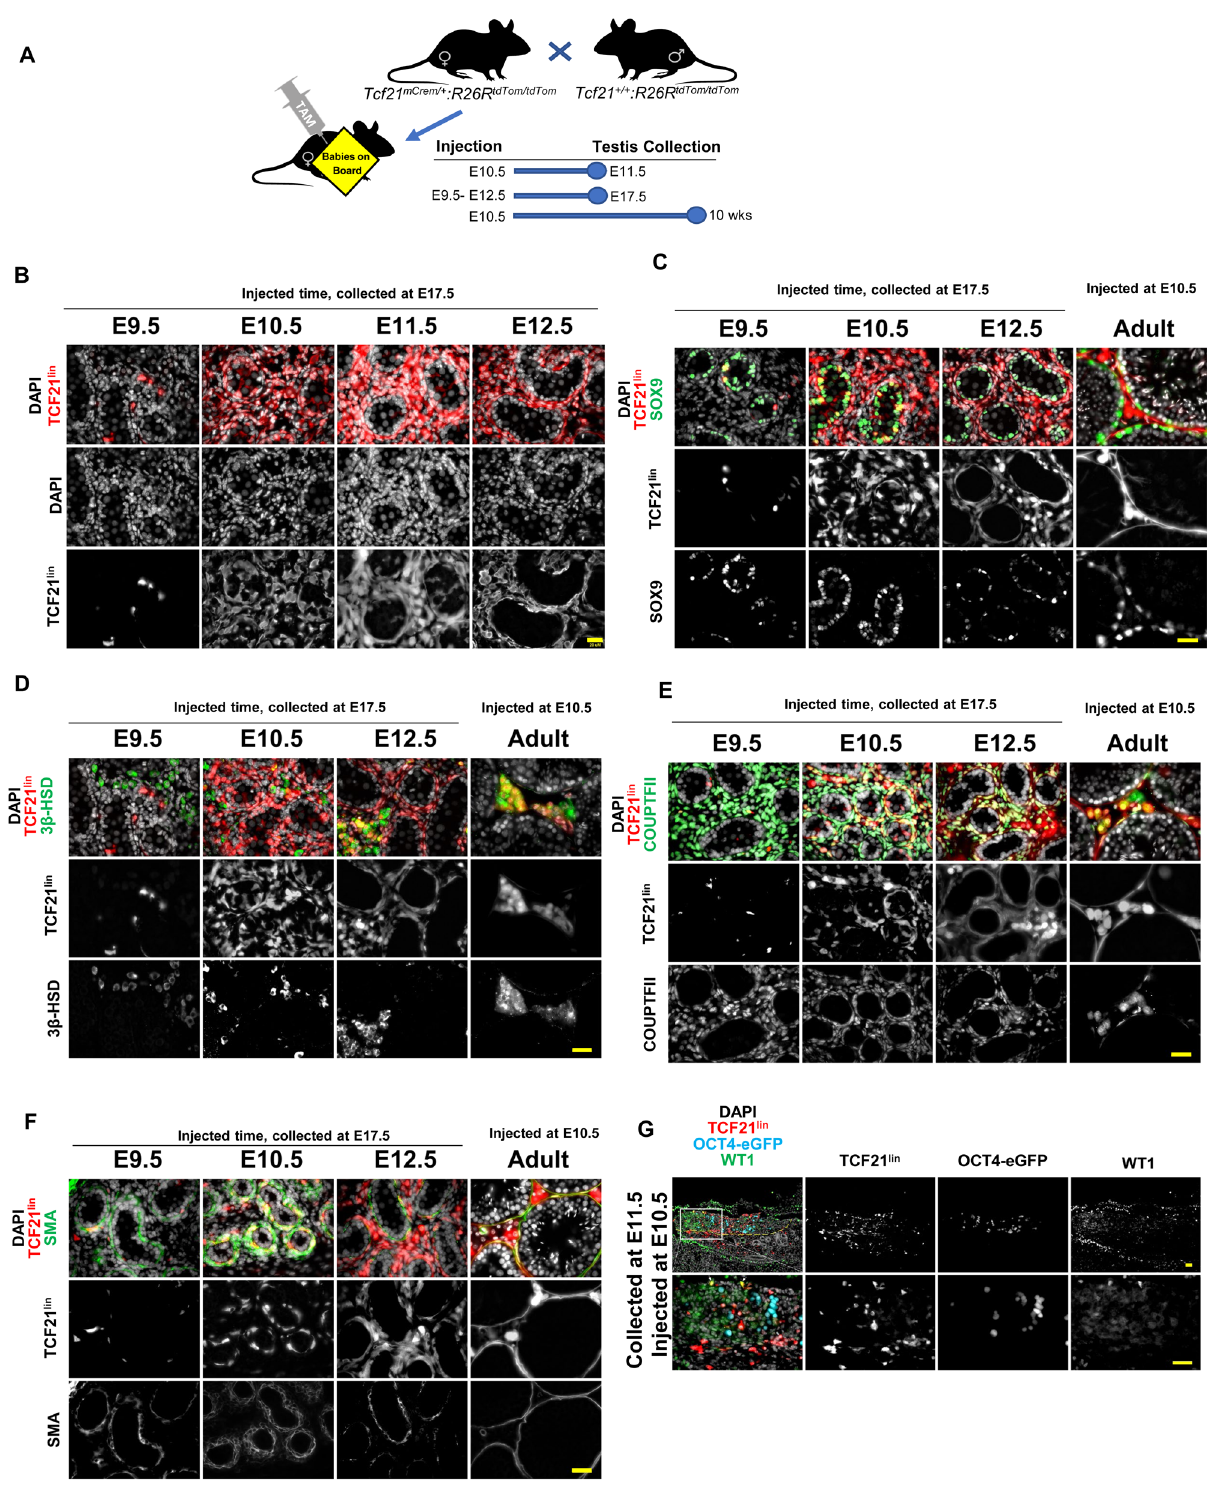
Fig. 4 The TCF21 lin population contributes to multiple somatic lineages in the fetal and adult testis. A Experimental timeline used for Tcf21 lineage tracing analysis. Tcf21 mCrem :R26R tdTom timed pregnant females were injected with a single dose of Tamoxifen at E9.5, 10.5, E11.5 or 12.5 and testes were analyzed at E17.5 or 10 weeks. B The TCF21 lin cells at E10.5 ( n = 17) and E11.5 ( n = 11) contribute to all major somatic cell populations in the fetal gonad, whereas the E12.5 ( n = 11) TCF21 lin cells give rise only to testis interstitial cells. C – F Co-immunostaining of fetal or fostered adult TCF21 lin testis cross- sections with Sertoli cell marker SOX9 (green; C , n = 5 for E9.5 and E12.5, n = 3 for E10.5), Leydig cell marker 3 β -HSD (green; D , n = 5 for E9.5, n = 3 for E10.5 and E12.5), interstitial cell marker COUPTFII (NR2F2; green in E , n = 5 for E9.5, E10.5, and E12.5), and a myoid cell marker alpha smooth muscle actin (SMA, green in F , n = 5 for E9.5, n = 3 for E10.5, n = 4 for E12.5). G The TCF21 lin in the fetal testis of Tcf21 mCrem ; R26R tdTom ; Oct4-eGFP embryos are present in both the coelomic epithelium and mesonephros. Colocalization of WT1 + (Green) cells in the E11.5 gonad with TCF21 lin cells ( n = 2). In all panels the nuclear counterstain is DAPI (white B – G , n = 2). Scale bars for all B – G : 20 μ m. NATURE COMMUNICATIONS| (2021) 12:3876 |https://doi.org/10.1038/s41467-021-24130-8|www.nature.com/naturecommunications